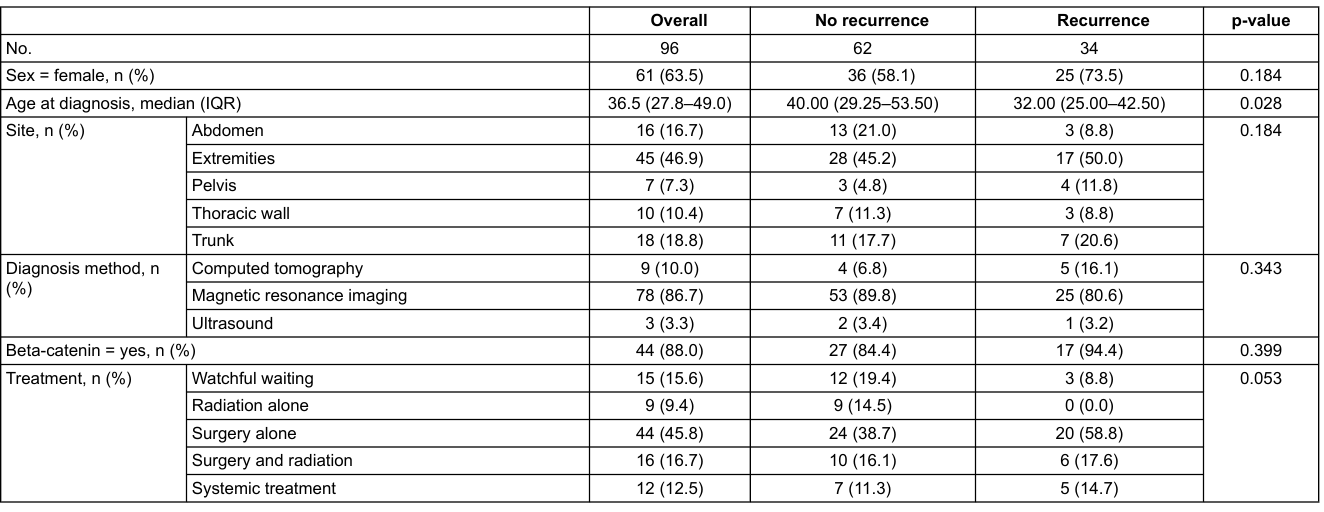
Table 1: Summary of patient